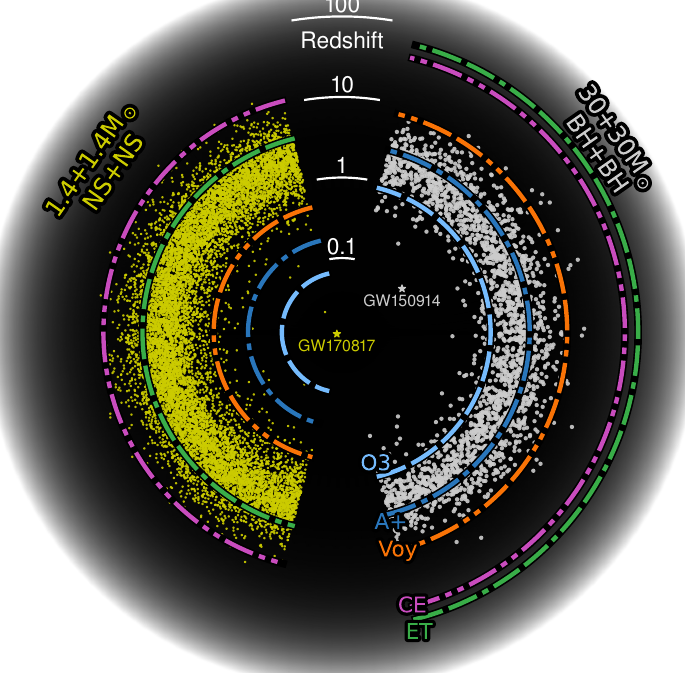
Figure 2. The cosmic history of binary stellar remnant mergers, with 1.4 + 1.4 M (cid:12) neutron star mergers on the left and 30 + 30 M (cid:12) black hole mergers on the right; the radial coordinate is cosmological redshift z . The distribution of mergers as a function of redshift assumes the Madau–Dickinson star formation rate and that the typical time from binary formation to merger is 100 million years [37, 38]; under these assumptions, most of these binaries merge at z ∼ 2. The first gravitational-wave detections of a binary black hole merger (GW150914) and a binary neutron star merger (GW170817) are indicated [39,40]. The colored bands then show the detection capabilities of selected gravitational- wave observatories from Figure 1, as well as the capability of Advanced LIGO during the third LIGO–Virgo observing